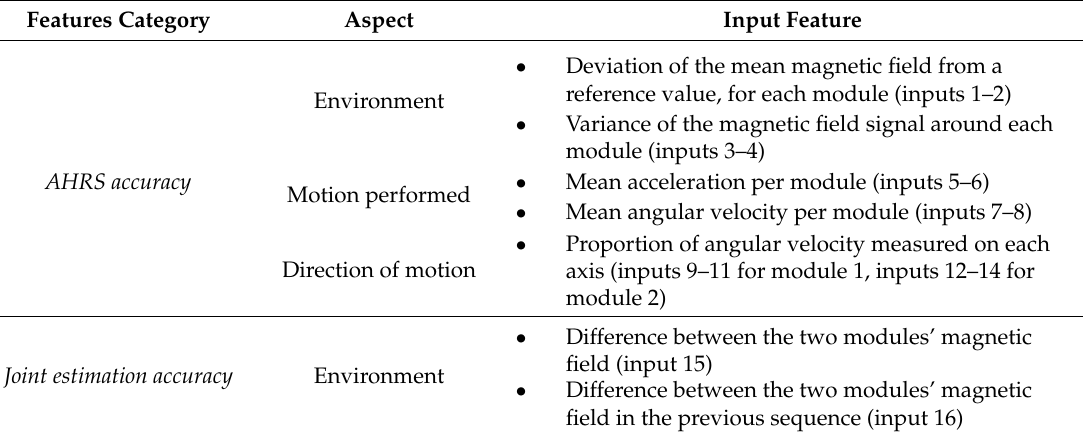
Table 1. QC Input